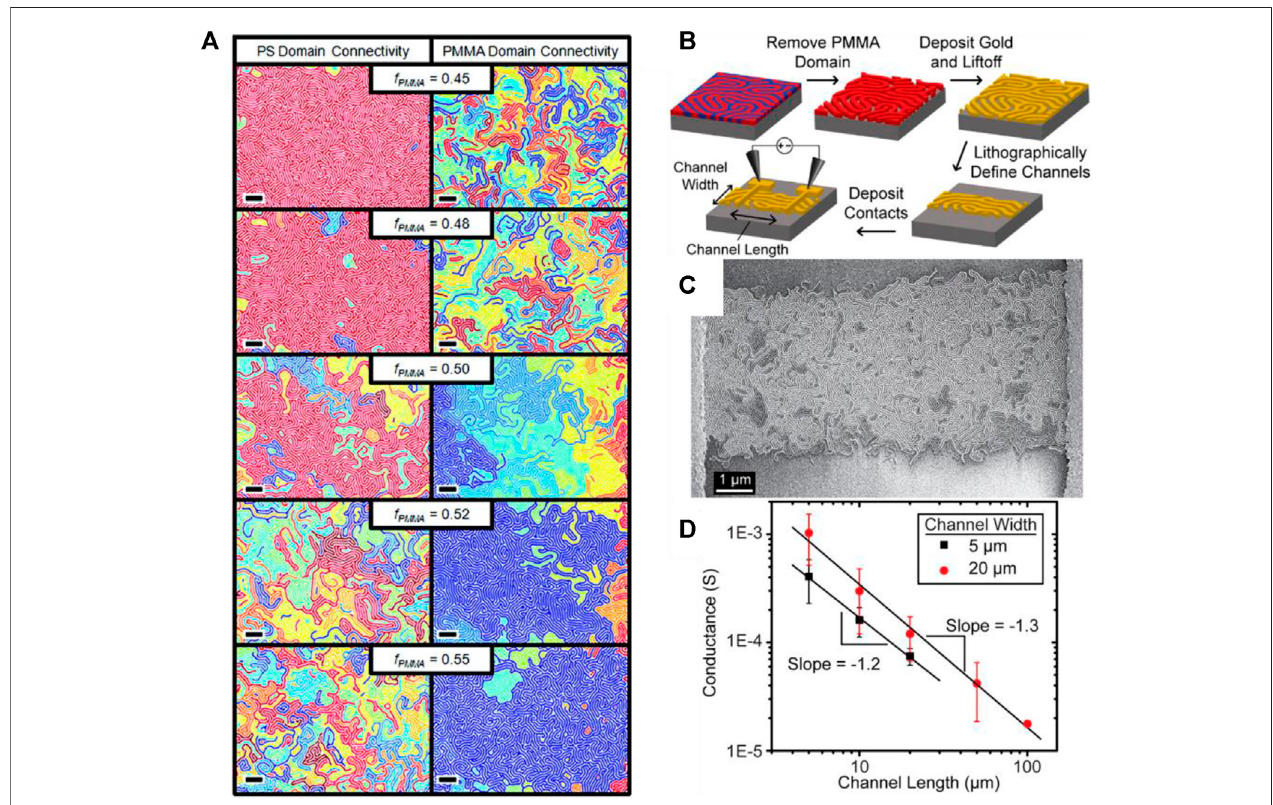
FIGURE3| (A) Percolation network ofPS (left column) and PMMA (right column) as thevolume fraction ofPS- b -PMMA isvaried.It canbe noted that when the PMMA volume fraction is decreased connected network spread in the PS domain is increased and vice versa. All the scale bars represent 400 nm; (B) Schematic showingtheprocess fl owforfabricationofdevicecontainingBCPderivednanowirenetworksformedbymetallift-off; (C) Scanningelectronmicrographofatwo-terminal device(10 μ mchannellength,5 μ mchannelwidth)fabricatedviaBCPtemplatedAunetwork; (D) ConductancevariationwithchannellengthfortheBCPtemplated Au nanowire networks using PS- b -PMMA (f PMMA (cid:1) 0.52) for channel widths of W (cid:1) 5 and 20 μ m. Reproduced with permission from ref (Campbell et al., 2012); (Diederichsen et al.,